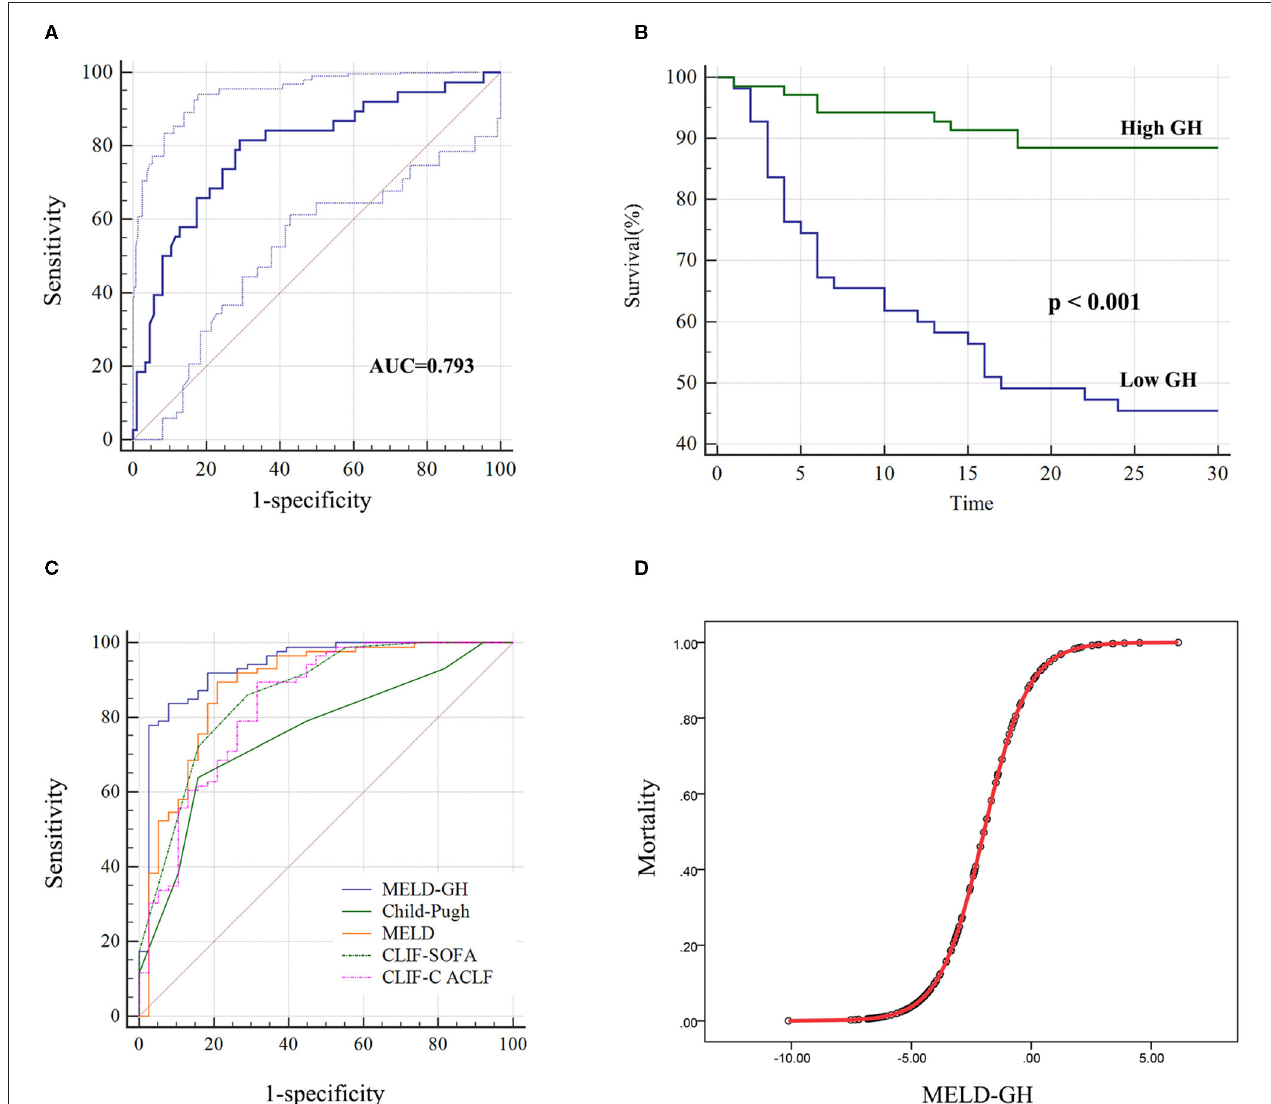
FIGURE 4 | Performance of GH on predicting 30-day survival of HBV-ACLF patients. (A) The AUC of GH predicting the outcome was 0.793, and low GH ( < 2,001 pg/ml) group (B) showed significantly worse 30-day outcome than high GH group. (C) MELD-GH score showed highest AUC than Child-Pugh, MELD, CLIF-SOFA, and CLIF-C ACLF scores. (D) The estimation of HBV-ACLF mortality based on MELD-GH